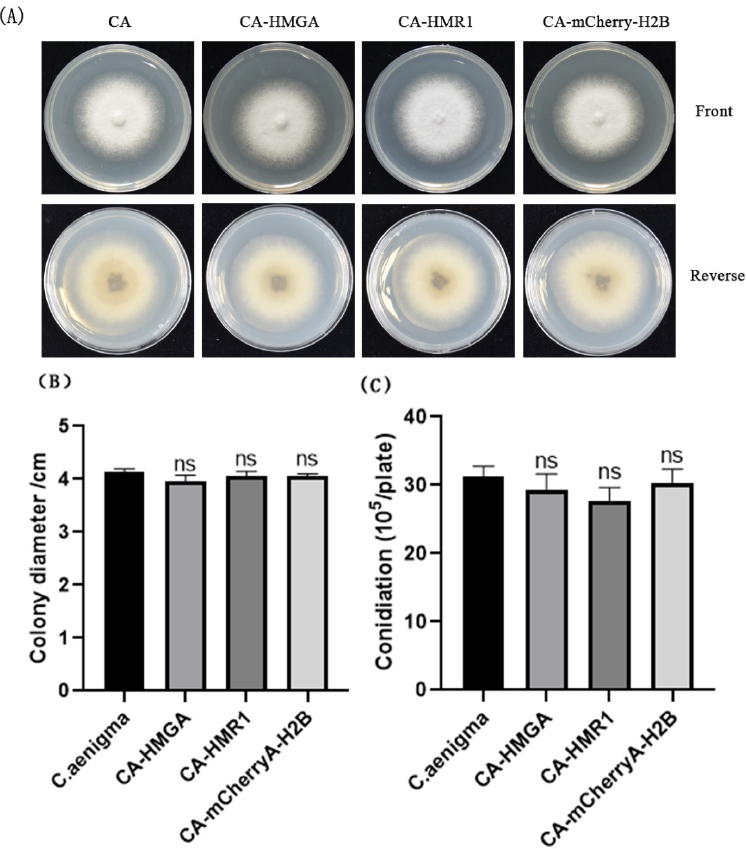
Figure 3. Colonial morphology, radial growth, and conidiation of the transformants. ( A ) colonies of the C. aenigma wide type and transformants cultured on CM for 3 days; ( B ) colonial dimeters of the strains cultured on CM for 3 days; and ( C ) conidiation of the strains cultured on CM for 3 days. ns: no signi fi cant di ff erence between transformants and C. aenigma . Secondly, several strains of C. aenigma , CA-HMGA, and CA-mCherry-H2B were se- lected to test virulence. After inoculating healthy grape leaves for three days, the inocula- tion site began to turn black (Figure 4A). Seven days later, the brown became darker and darker, the lesion area also expanded continuously (Figure 4B), and it began showing the symptoms of grape anthracnose. Brown disease spots also appeared in the fruit three days after inoculation (Figure 4D) and the disease became more serious seven days later (Figure 4C). At the same time, all of the leaves and fruits inoculated with spore suspension or my- celial blocks showed the above symptoms. While the grape leaves in the control group and the non-injury inoculation group had no susceptible symptoms, these results show that the random insertion of foreign genes will not make the pathogenicity of C. aenigma disappear.